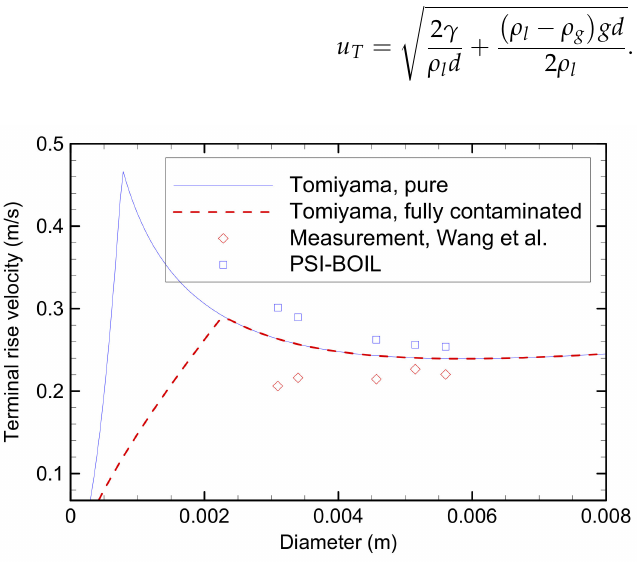
Figure 11. Comparisons of terminal rise velocity for B 0 = 0 between the Tomiyama correlations [42], the measurements of Wang, et al. [7] and the simulated values obtained in this